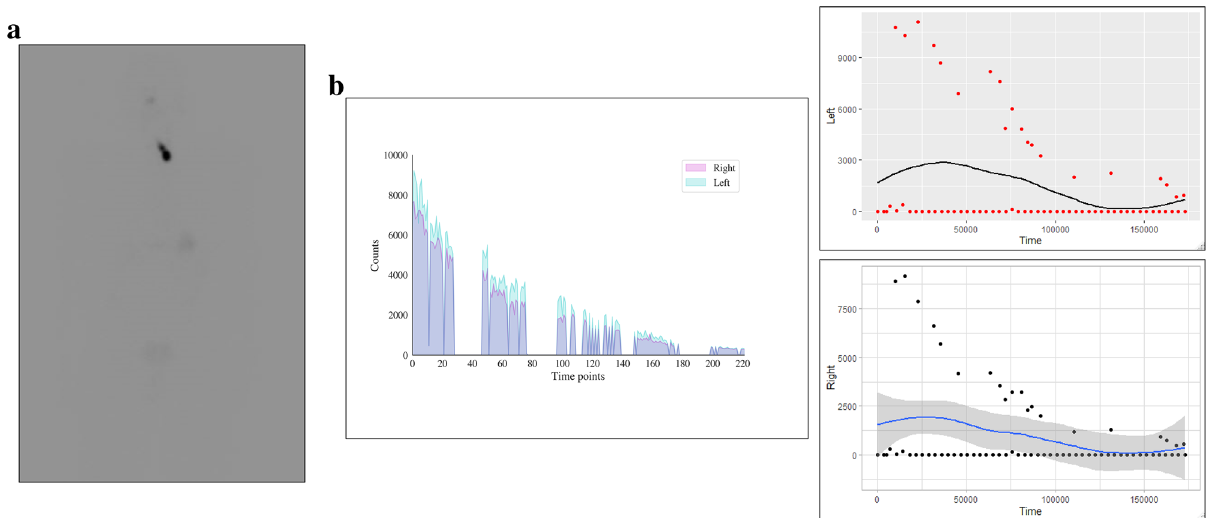
Figure 4. ( a ) Second DTC Patient (Patient 4) Whole body planar image showing intense uptake in the neck at the site of remnant on the left side with extension medially with suppression of the rest of the body. ( b ) Second DTC Patient (Patient 4)-I-123 COTI measurements : Left- Superimposed right and left side over time points, right upper- left side COTI measurements over time in seconds , right lower— right side COTI measurements over time in seconds(absolute counts shown). ( c ) Second DTC Patient (Patient 4): Left— Post-131 planar image, Right -Post-131 SPECT/CT showing left sided intense uptake with minimal uptake on the right. ( d ) Second DTC Patient (Patient 4)-I-131 COTI measurements : Left- Superimposed right and left side over time points(high uptake in the left compared to right), right upper— left side COTI measurements over time in seconds , right lower— right side COTI measurements over time in seconds (left sided uptakes are significantly higher as seen by the scaling in the Y